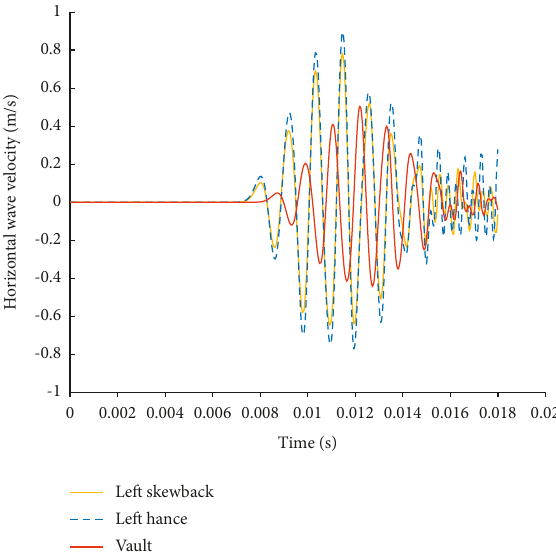
Figure 9: Horizontal wave velocity of each measuring point in tunnel without discontinuity.